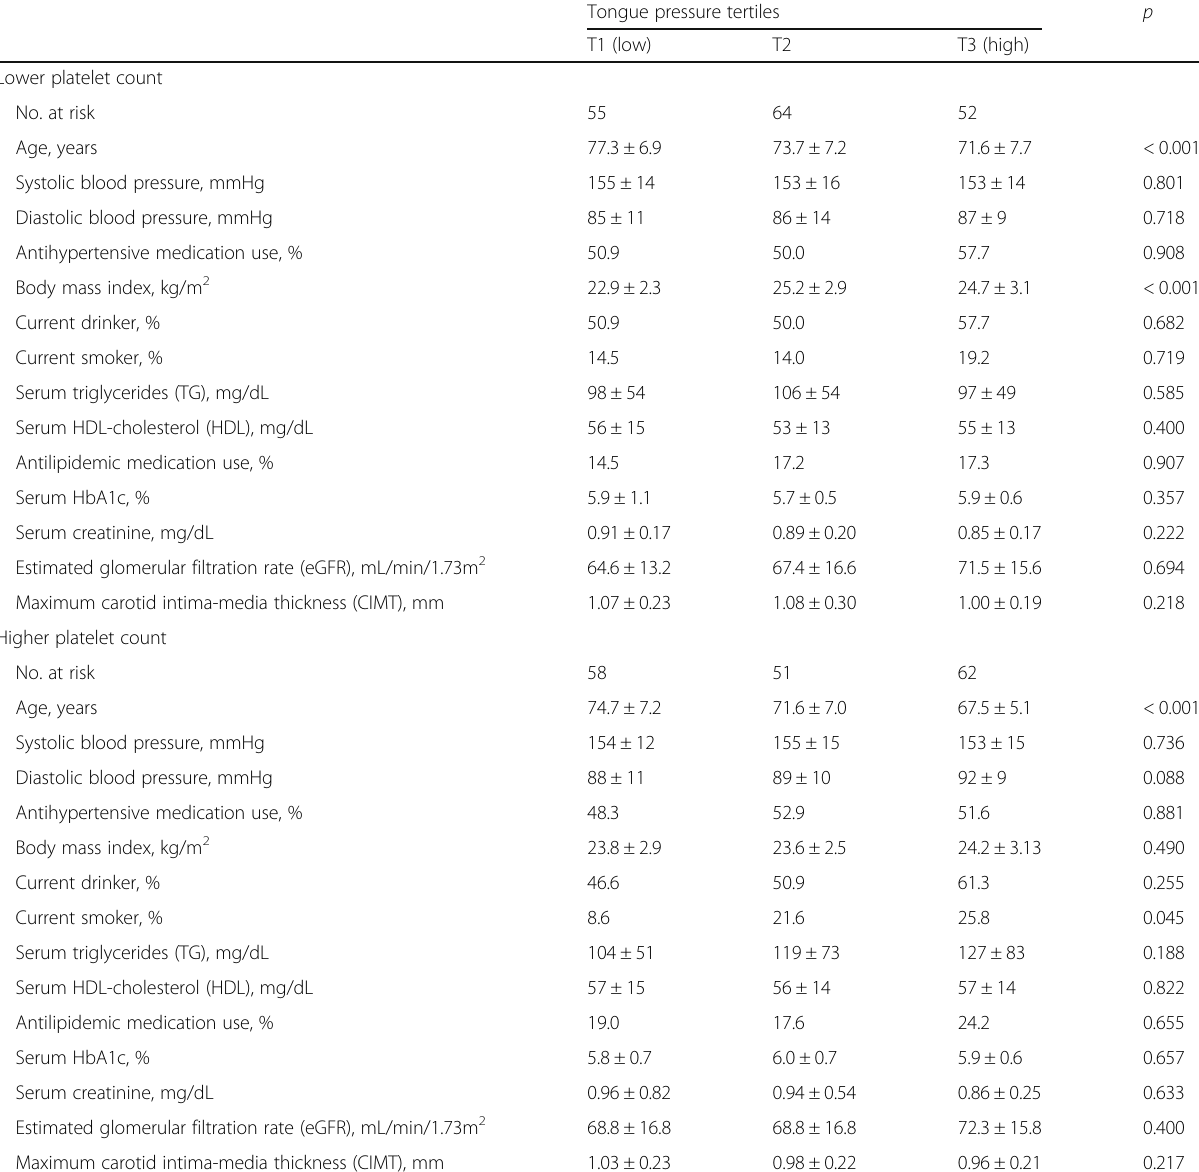
Table 2 Platelet level-specific characteristics of the study population based on tongue pressure level